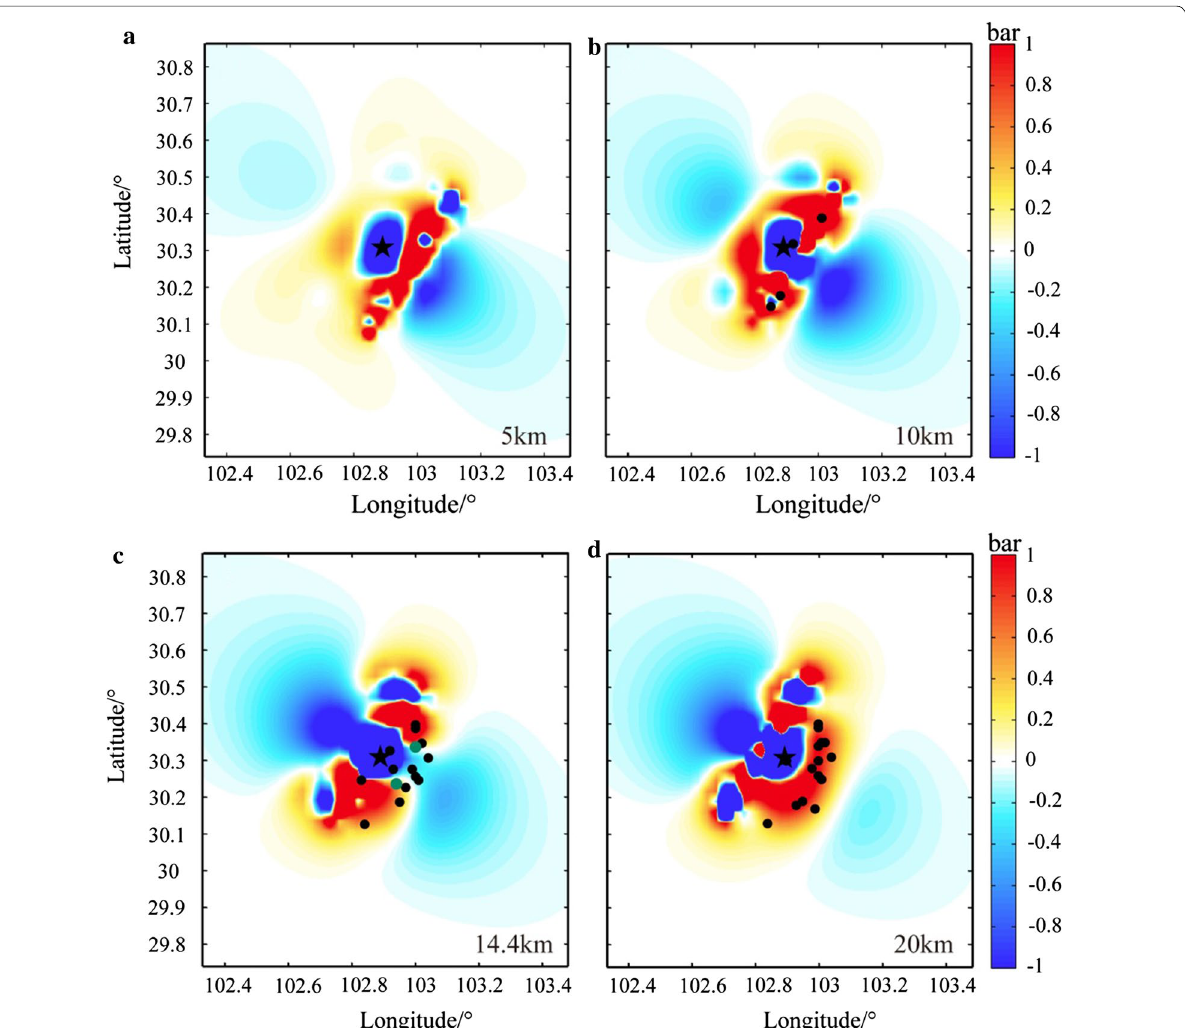
Fig. 6 Stress changes imparted by the 2013 Lushan earthquake at different depths with an effective friction coefficient of 0.4. a 5 km, b 10 km, c 14.4 km and d 20 km. The black circles represent M L 4 aftershocks in 1 day after main-shock and their depths are limited between the calculated ≥ depth of 3 km. Grey circles in c are the two largest aftershocks (M ±